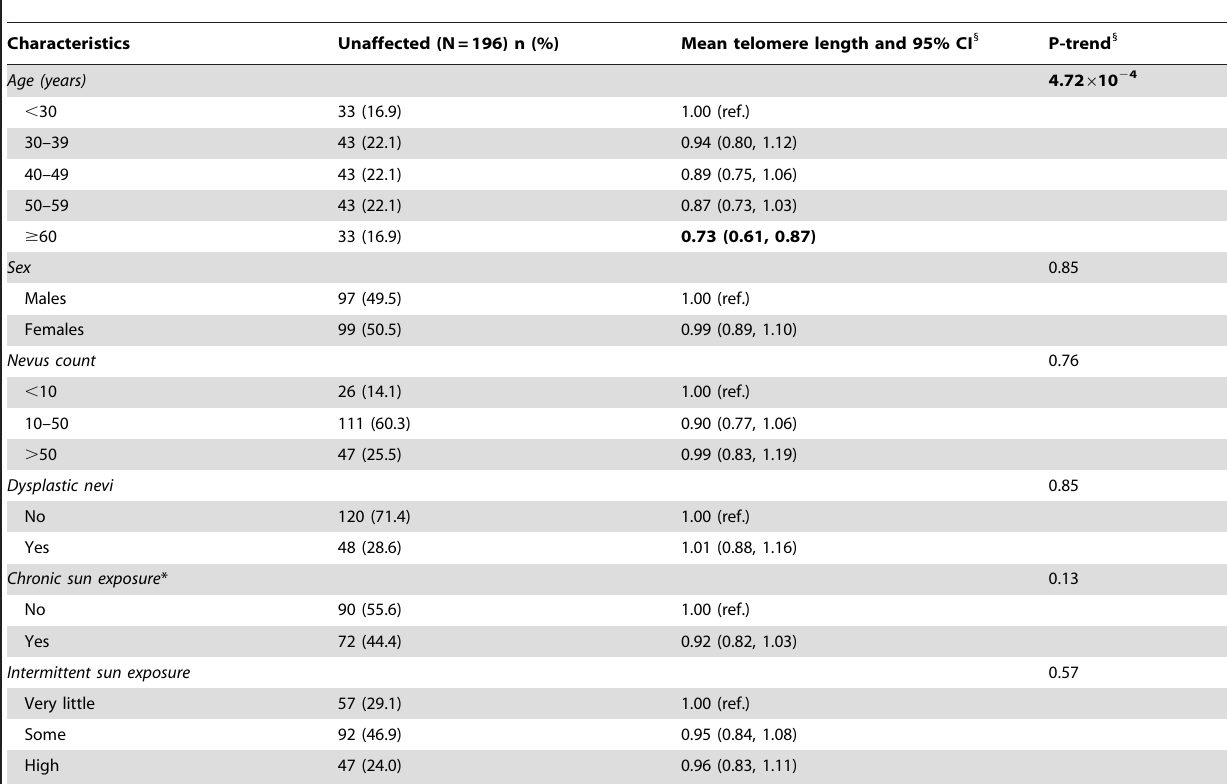
Table 4. Relationship of telomere length with demographic and sun related characteristics in non-melanoma subjects.